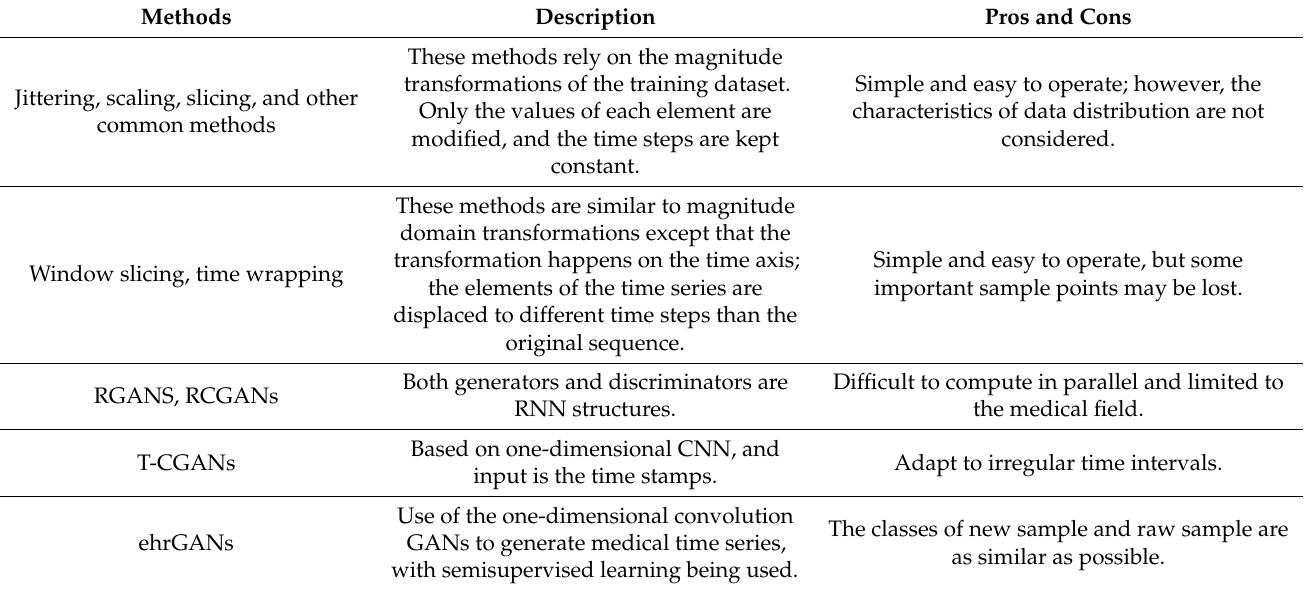
Table 1. Comparison of augmentation methods for time